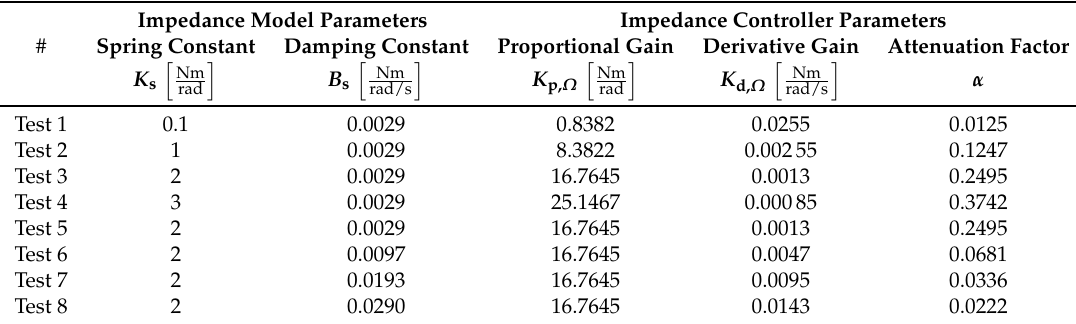
Table A2. Impedance model and controller parameters.